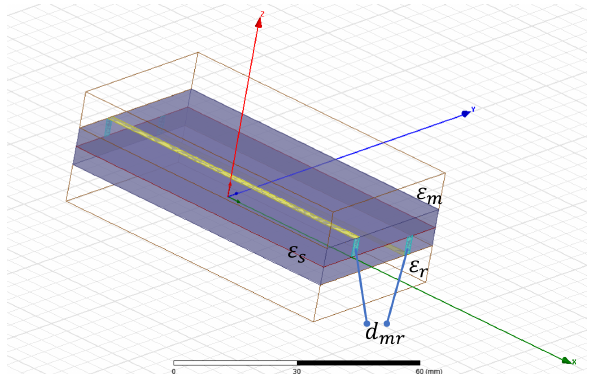
Figure 11. General model of microstip sensor proposed ( L = 25 mm, width = 10 mm, height = 2 mm and patch line = 0.8 mm). Numeric differential measures ( d mr ) can be obtained to characterize dielectric medium unknown ( (cid:101) m ), knowing reference permittivity ( (cid:101) r ) and microstrip substrate ( (cid:101) s